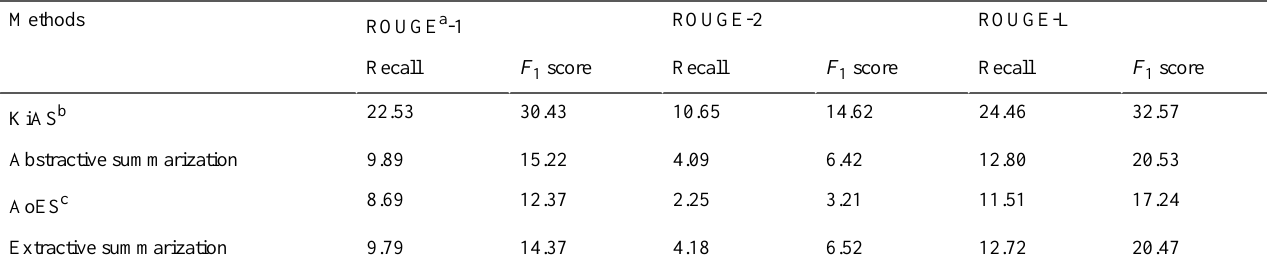
Table 3. Quantitative Recall-Oriented Understudy for Gisting Evaluation (ROUGE)-1, ROUGE-2, and ROUGE-L results on the summarization task of clinical diagnostic interviews. All the scores have a 95% CI of at most ±0.18